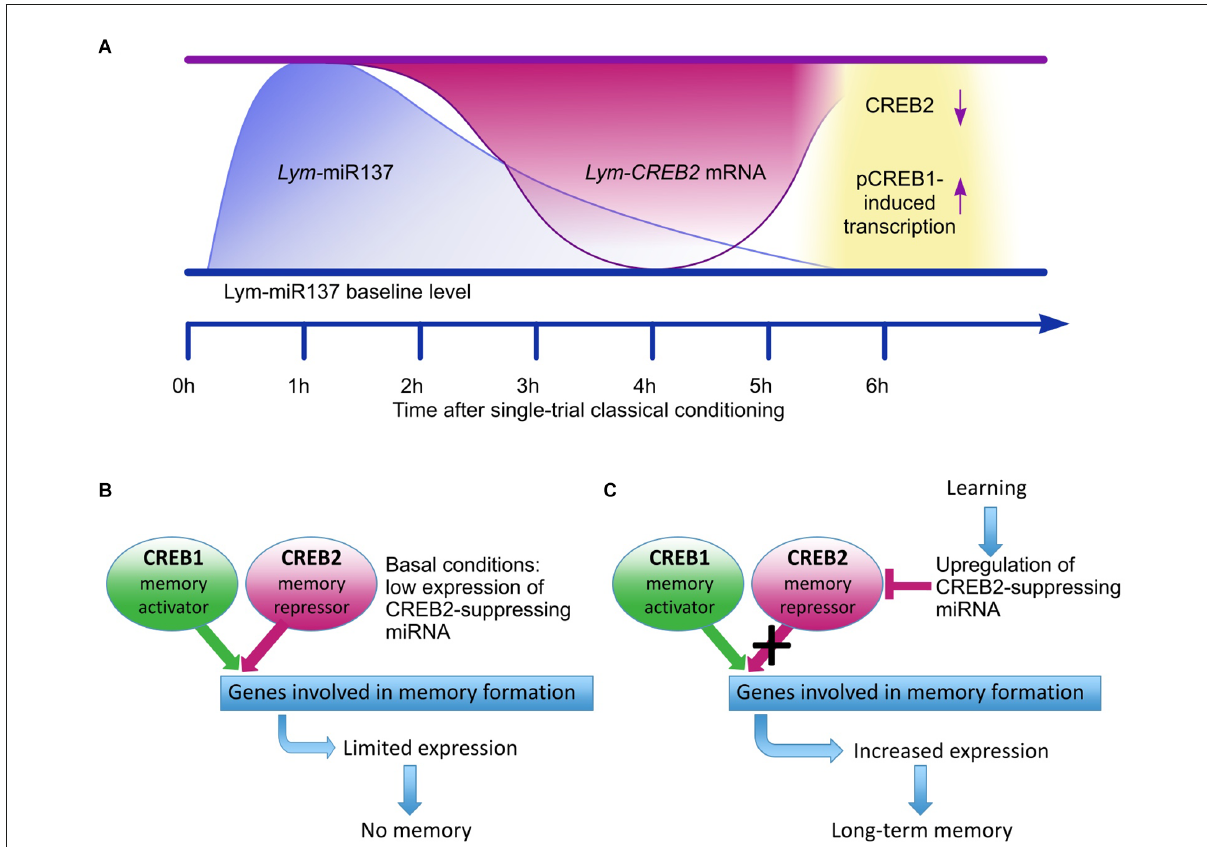
FIGURE1 Adapted from Korneev et al. (2018). Schematic model for the proposed role of Lym-miR-137 in the regulation of CREB-dependent LTM formation in Lymnaea . (A) A schematic of the proposed temporal relationships between the learning-induced changes in Lym-miR-137 and Lym-CREB2 mRNA levels and pCREB1-induced gene transcription. Lym-miR-137 levels were measured at 1h and 6h post-training, Lym-CREB2 mRNA levels were measured at 4h and 6h post-training, pCREB1 levels were measured, and transcription dependence established at 6h post-training (Korneev et al., 2018). (B) Under basal conditions, CREB1 and CREB2 compete for binding to the cAMP response elements (CRE) of target genes. Consequently, expression of CRE-dependent genes remains limited. (C) Single-trial training increases Lym-miR-137 expression resulting in down-regulation of CREB2. The repressive effect of CREB2 is decreased and CREB1 activates the expression of target CRE-dependent genes required for LTM